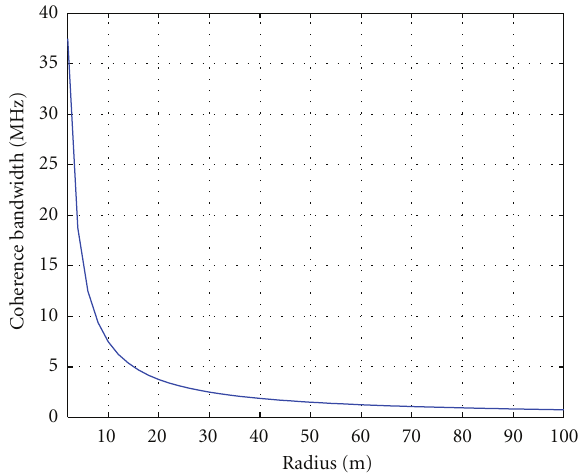
Figure 12: The minimum coherence bandwidth of 2 × 2 DP system varies with upper radii of spheres of scatterers in both Tx and Rx.